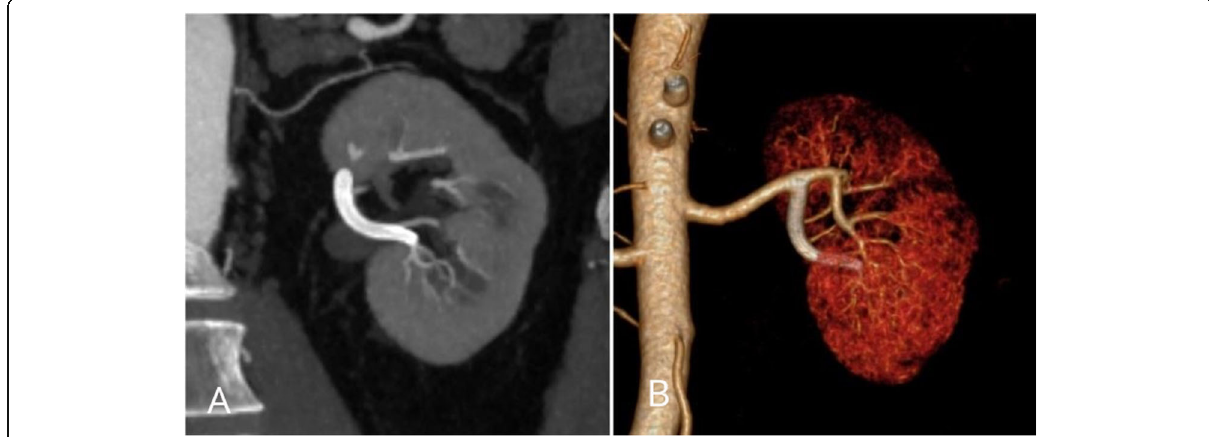
Fig. 5 3-week follow up CTA. a ) coronal MIP CTA and corresponding 3D volume rendered imaging demonstrating complete thrombosis